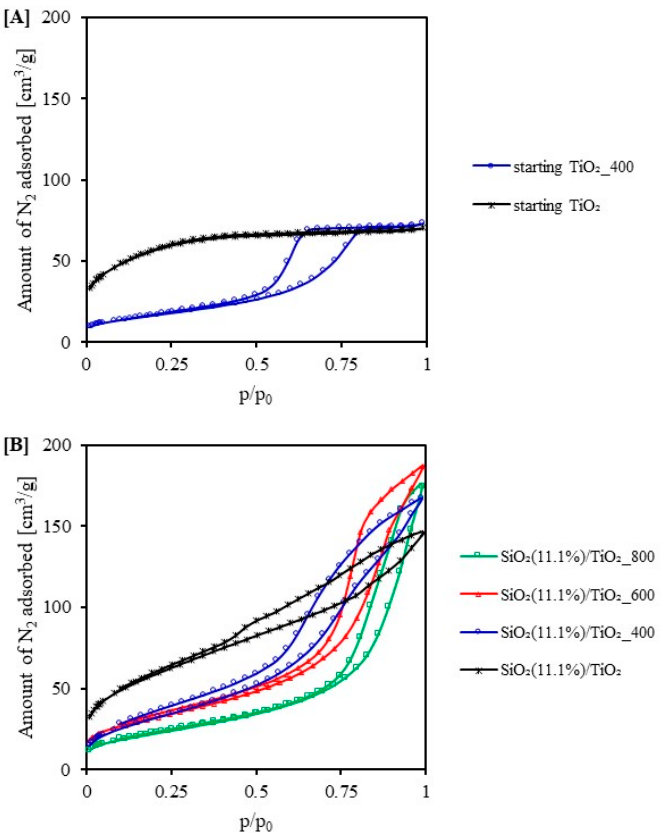
Figure 2. N 2 adsorption-desorption isotherms for starting TiO 2 and starting TiO 2 _400 ( A ) and fumed silica-modified TiO 2 prior and after heat treatment ( B ). Table 2. Specific surface area and band gap